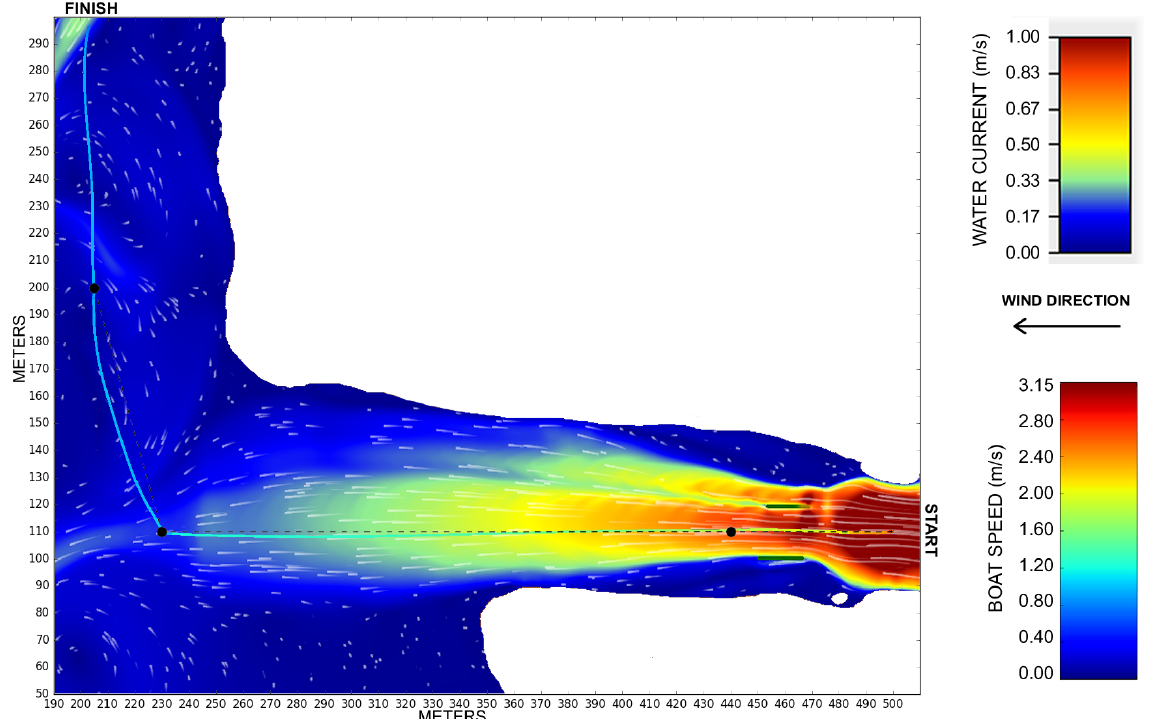
Figure 8. Trajectory of a differential boat in the environment presented in Figure 5. The trajectory color represents the boat speed along the